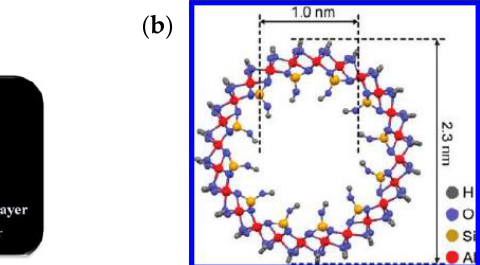
Figure 3. ( a ) Structure of attapulgite nanorod. Reproduced with permission from [46], published by Royal Society of Chemistry, 2016. ( b ) Aluminosilicate single-walled nanotube. Reproduced with permission from [48], published by American Chemical Society, 2012.